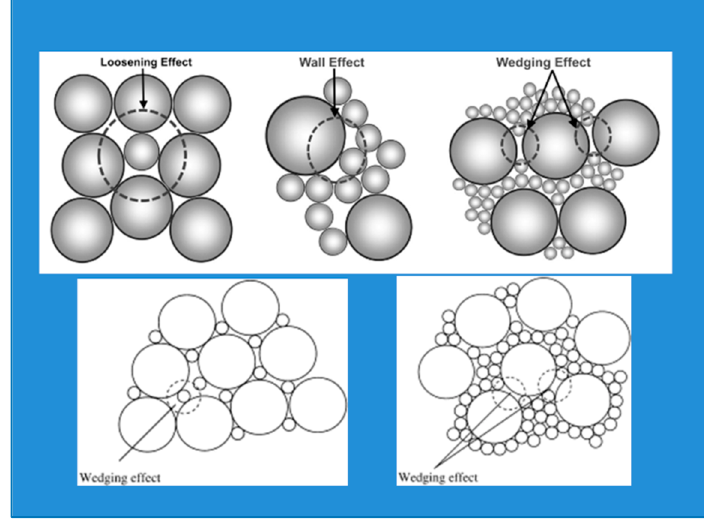
Figure 4. Schematic representation of particle interactions [5–7].